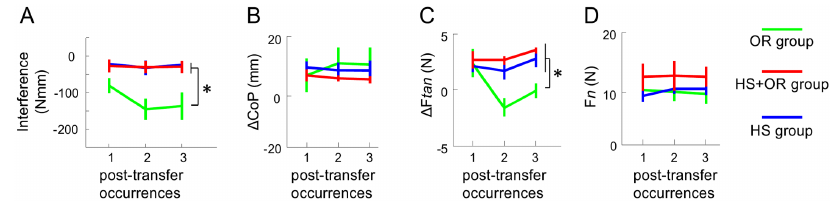
Figure 5. Interference in post-transfer trials. Panel A shows the interference (see text for details) across three post-transfer occurrences for three transfer groups, HS (blue), HS + OR (red), and OR (green). Panels B–D show digit placement ( D CoP) and digit forces ( D F tan and F n ) from three transfer groups across three post-transfer trials. The asterisks denote significant differences ( p , 0.05) obtained from post hoc comparisons between groups across multiple occurrences (see text for details). Data are averages of all subjects and vertical bars denote standard errors of the